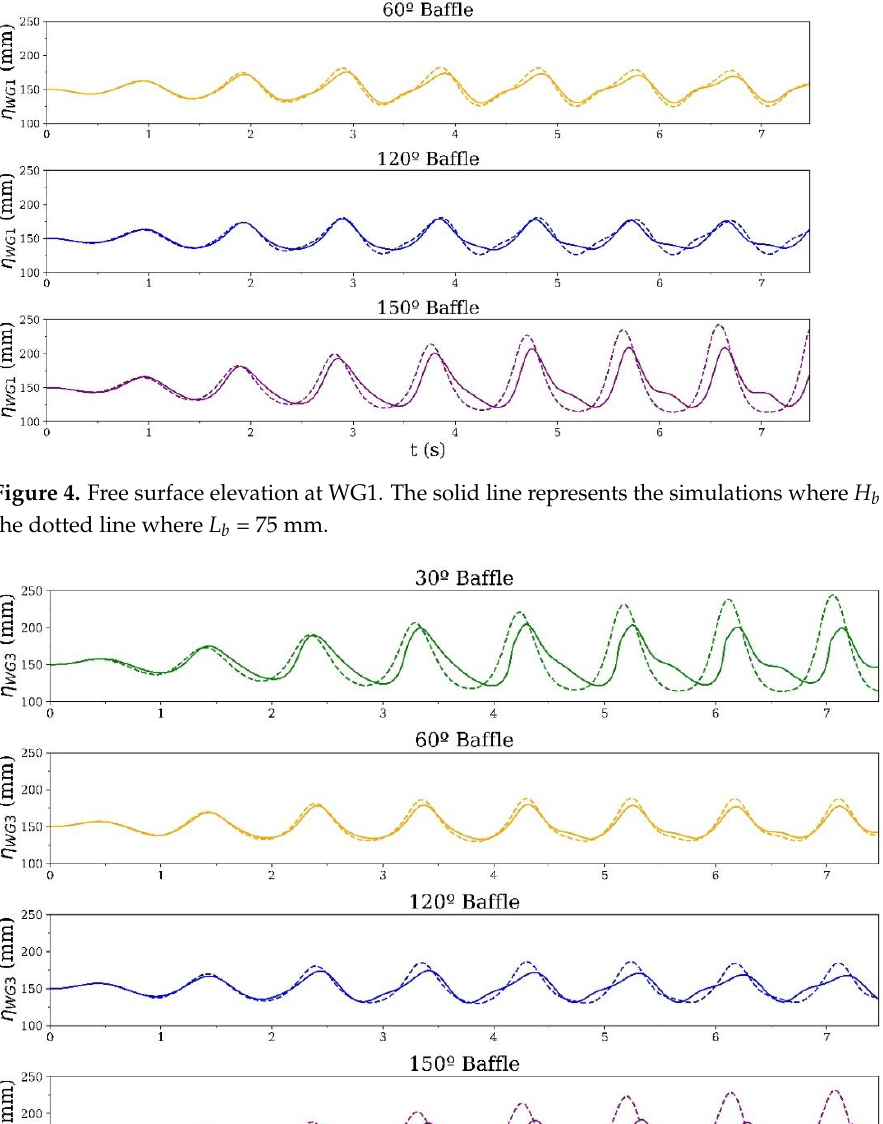
Figure 6. Maximum free surface elevation through time, that is, the height of the wave through the simulation time. Given how the induced wave energy is proportional to the square of the free surface elevation, 𝐸 𝑠 =∝ 𝜂 𝑚𝑎𝑥 2 (Xue et al. [18]), different baffle angles can be compared against the simulation without a baffle using an energy dissipation rate 𝜉 :